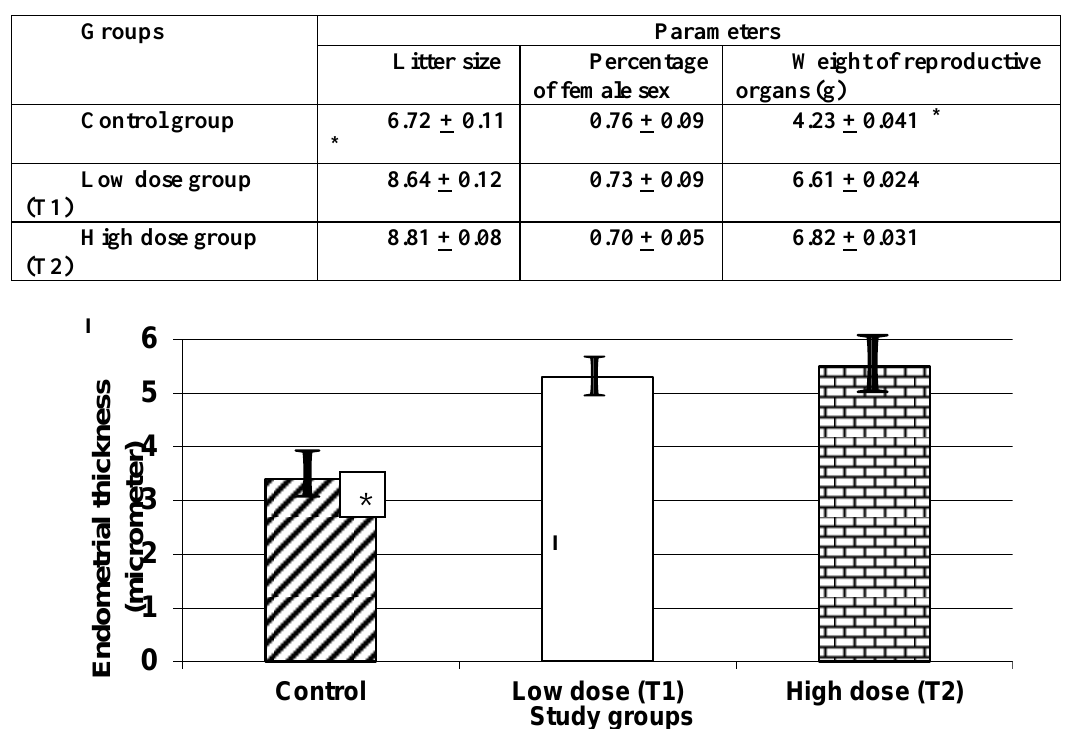
Table 1: Litter size, percentage of female sex and weight of reproductive organs for pregnant mice # administered two doses of L-carnitine throughout pregnancy (No.=35 pregnant mice/group; Mean+ S.E.)